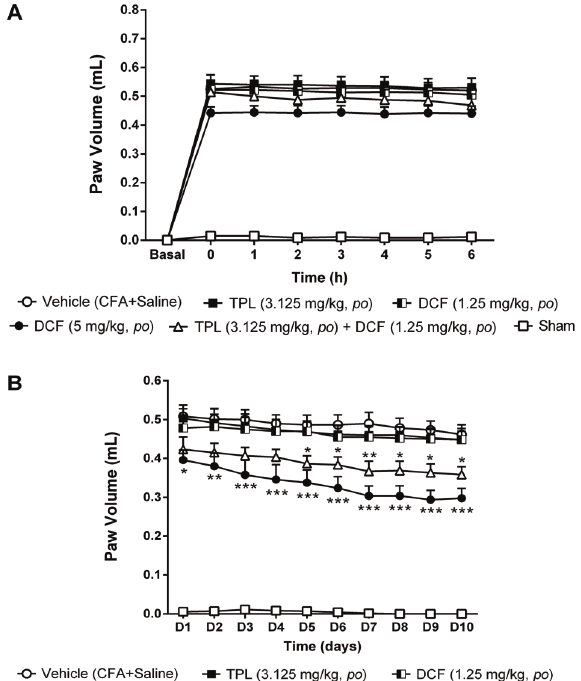
Figure 8. Effect of acute ( A ) and chronic ( B ) administration of terpinolene monoterpene (TPL)/diclofenac (DCF) association on the paw edema induced by CFA in female rats (n=6 – 8). Each point represents the mean ± SEM of the paw volume (mL) before CFA injection (i.e., baseline) or at the times indicated thereafter. *P o 0.05, **P o 0.01 and ***P o 0.001 compared to vehicle group (two-way ANOVA, Bonferroni test).